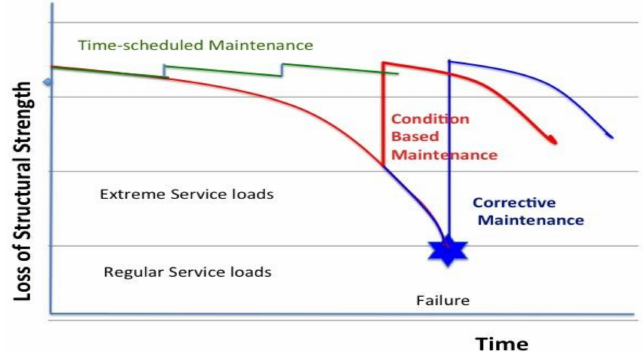
Figure 1. Maintenance strategies with / without structural health monitoring